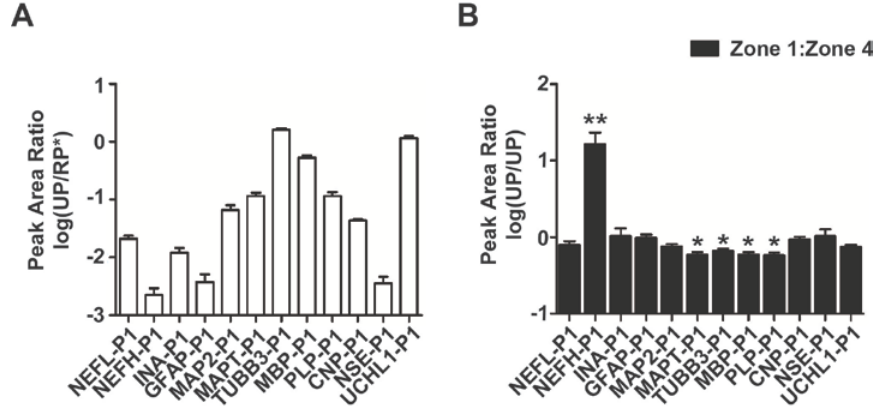
Figure 6. Abundance and stability analysis of protein biomarker candidates by